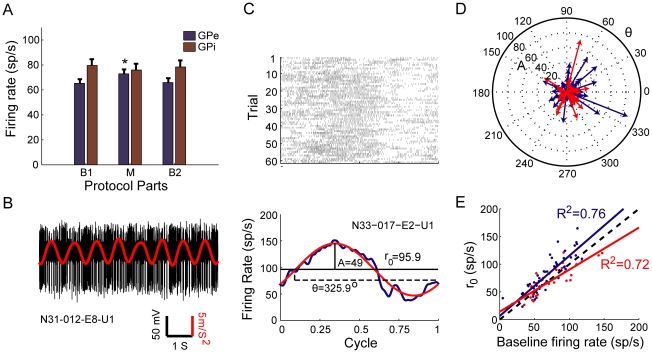
Single neuron movement encoding in the GP.
A, Mean firing rates (±SEM) of GPe (blue) and GPi (red) neurons during different parts of the experimental protocol. * p<0.001. B, Example of a raw spike train recorded from a GPi neuron during movement (black). The simultaneously recorded filtered accelerometer signal is superimposed (red). C, Example of a raster (top) and mPETH (bottom, blue) of a GPe cell. The red curve indicates the sine fit for the mPETH, and its parameters are shown (R2 = 0.96): horizontal solid line indicates r0, horizontal dashed line indicates the phase and vertical line indicates the amplitude. D, Compass plot of the sine fit phase (direction of arrow) and amplitude (length of the arrow) of all analyzed cells. E, Scatter plot of the firing rate prior to movement relative to the r0. The regression lines are shown in solid lines, dashed line indicates equality line. In D,E, GPe neurons in blue, GPi neurons in red.